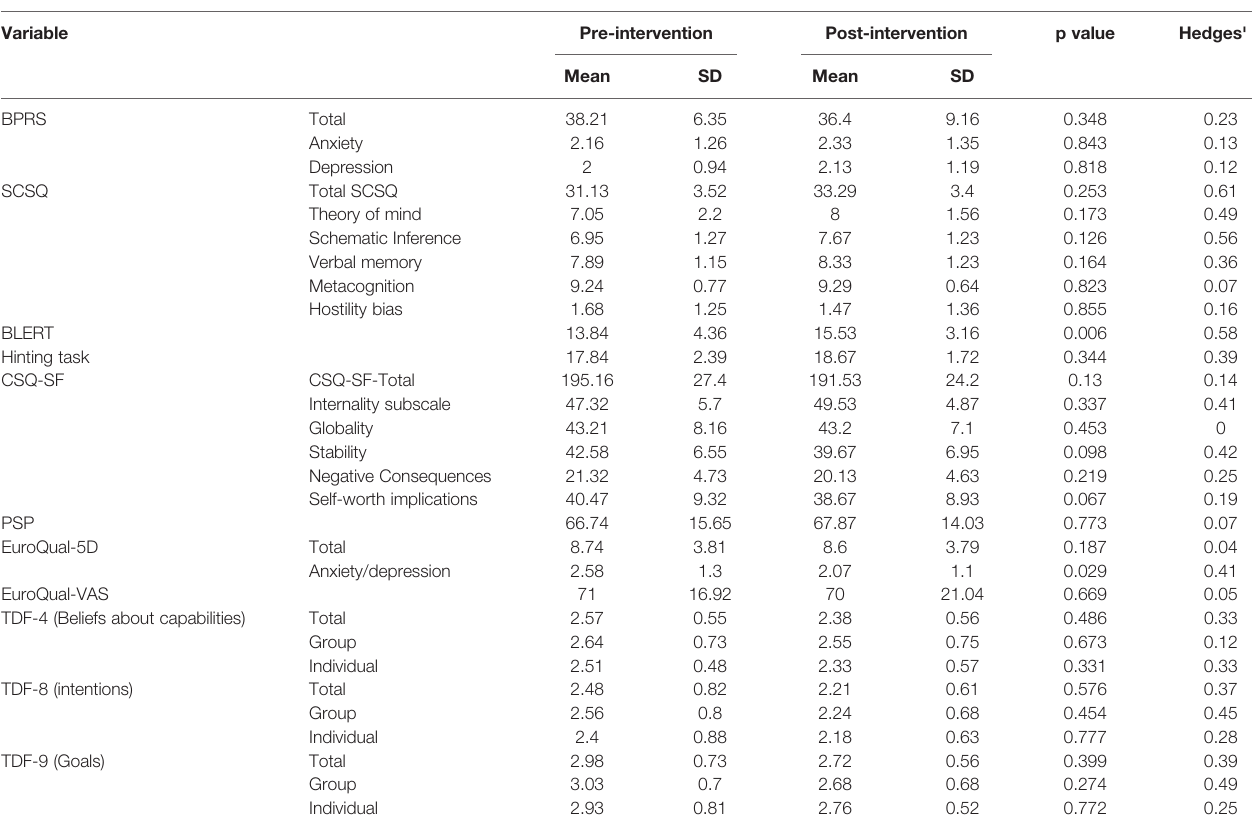
TABLE 5 | Pre- and post-intervention means and SDs for secondary outcomes. Variable Pre-intervention